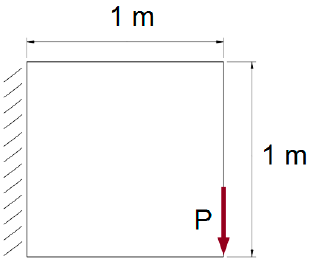
Figure 8. Initial structure with applied loads and supports, example 1.